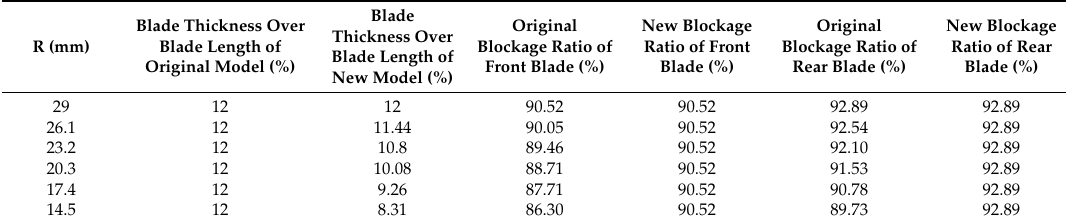
Table 2. The new blockage ratio and blade thickness of the front and rear rotor.